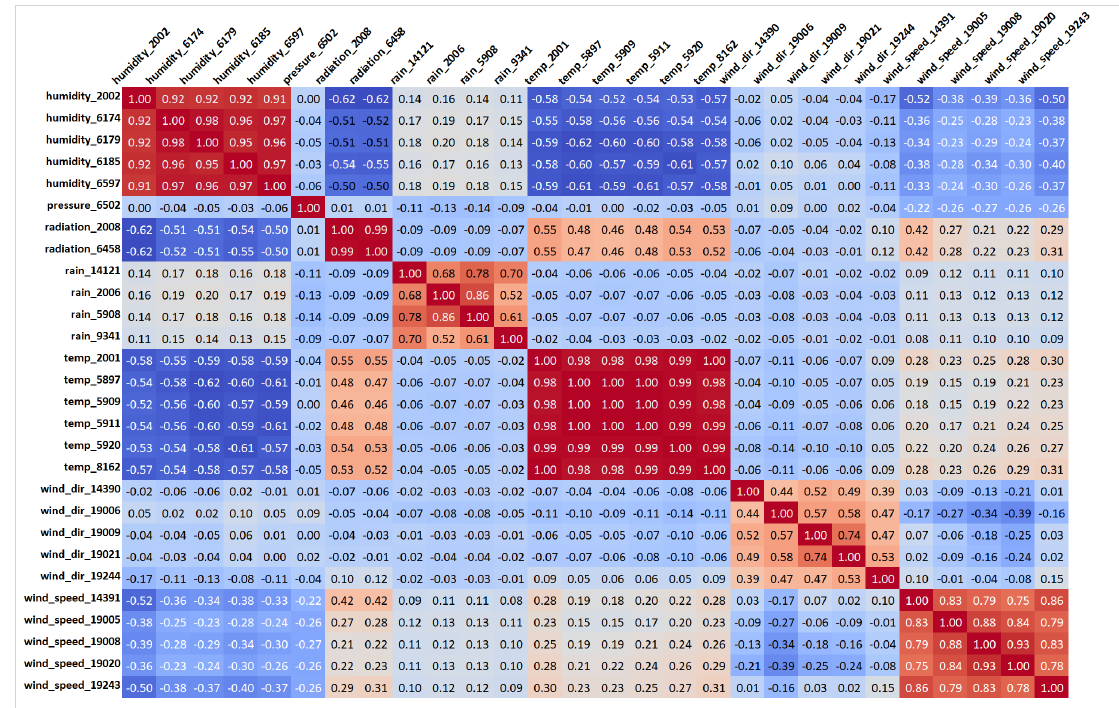
Figure A1. Correlation among unique pollutant sensors.